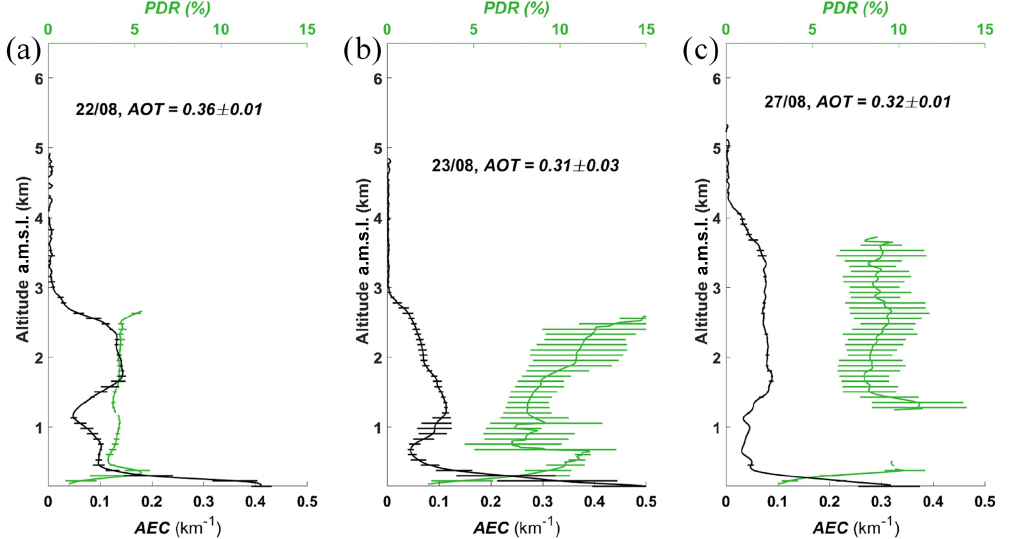
Figure 3. Vertical profiles of the aerosol extinction coefficient (AEC) and particle depolarization ratio (PDR) at 355nm with their uncertain- ties (horizontal bars) for period P 1 on (a) 22 (14:00–23:00UTC), (b) 23 (16:45–23:30UTC) and (c) 27 (15:45–17:00UTC) August 2017. The total AOT at 355nm is also given for each profile with its